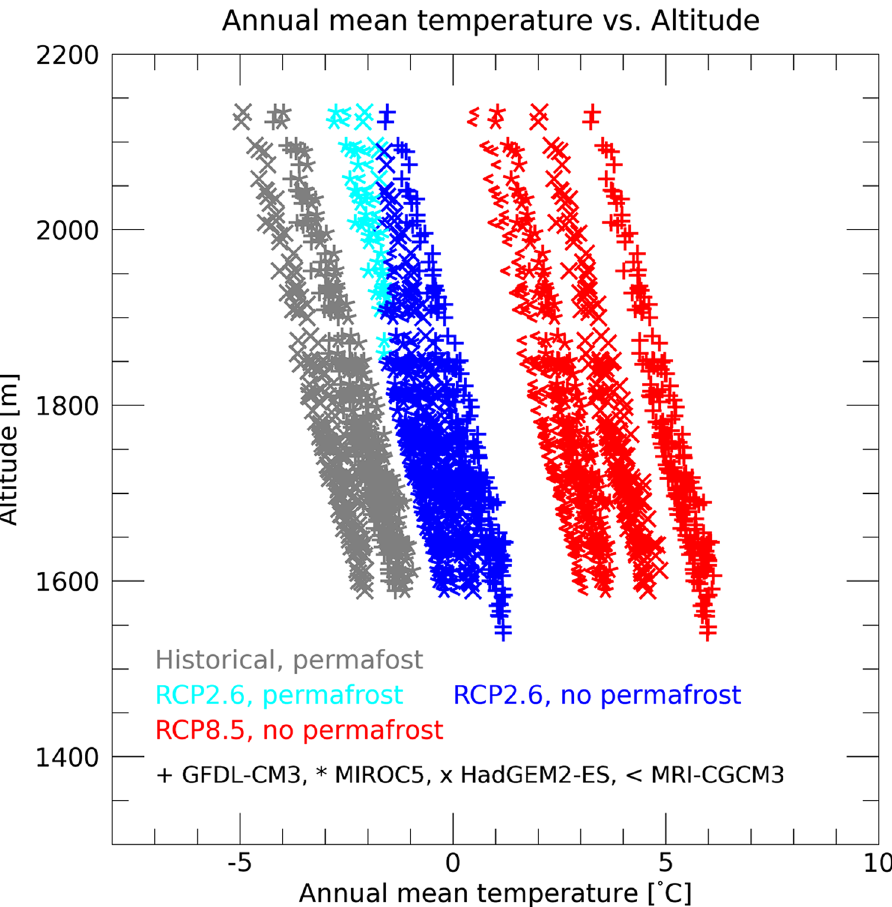
Figure 4. Scatter plot of altitude-annual mean surface air temperature in the Daisetsu Mountains. Each point represents the output of an individual grid cell. Only grid cells where the climatic conditions suitable for the development of permafrost (environmentally conditioned permafrost, ECP region) in the historical simulations are plotted (2001–2010: gray). These points are plotted separately in the ECP region (cyan) and the non-ECP region (blue) in the year 2100 under the RCP2.6 scenario. Since there is no ECP region in the year 2100 under the RCP8.5 scenario, all of the points are plotted in red. The symbols represent outputs from the four global climate models of the bias-corrected climate